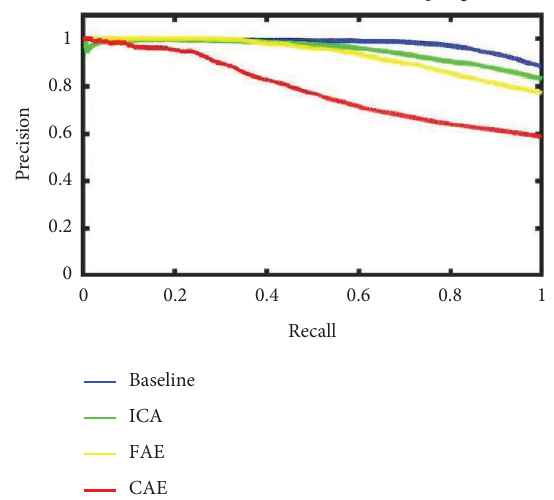
Figure 15: Precision-recall curves of the baseline and proposed algorithms on the summer-spring